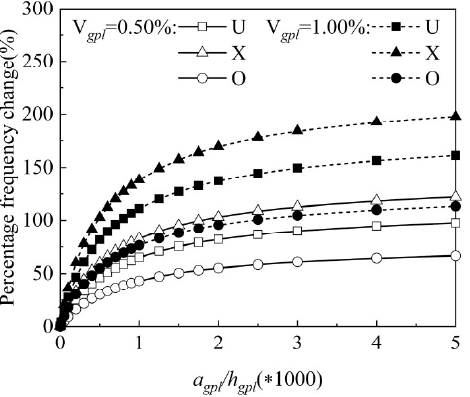
Figure 8. Variation of the percentage frequency change along the graphene length-to-thickness ratio for an SSSS FG-GRP plate.